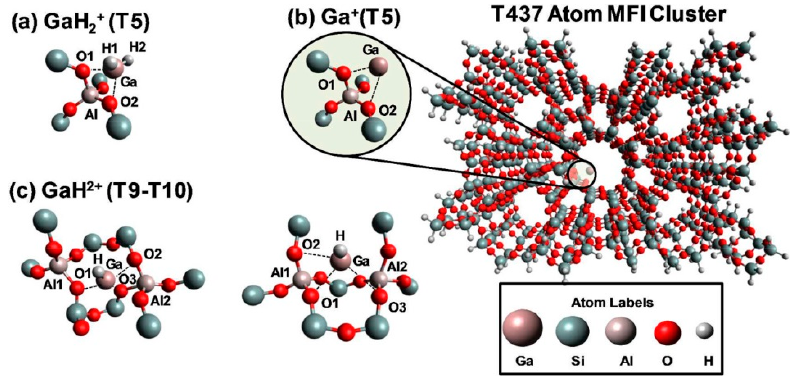
Figure 5. View along the [10] axis of T437 atom MFI structure used to model Ga-exchanged sites in Ga-modified ZSM-5. ( a ) [GaH 2 ] + ; ( b ) Ga + ; ( c ) [GaH] 2+ . Reprinted with permission from ref [94]. Copyright 2018 American Chemical Society.